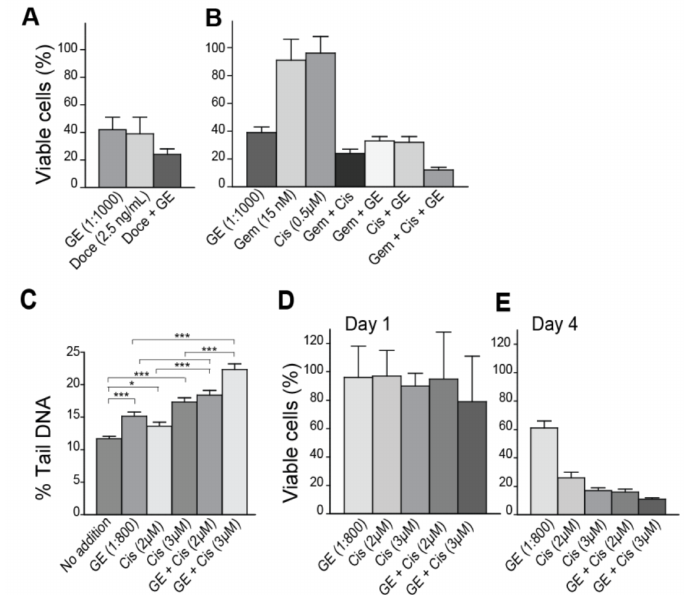
Figure 2. GE inhibits growth and increases the efficacy of genotoxic drugs in breast cancer cells. ( A , B ) Viability of the breast cancer cell line 67NR, measured by MTT-assay on day four, after the addition of ( A ) GE (diluted 1:1000), docetaxel (Doce) (2.5 ng/mL), and a combination of these at same concentrations; and ( B ) GE (diluted 1:1000), cisplatin (Cis) (0.5 µ M), gemcitabine (Gem) (15 nM), and double and triple combinations of these at the same concentrations. ( C ) Comet assay on 67NR cells on day one (16–20 h), after the addition of GE diluted at 1:800, alone and in combination with high dose cisplatin (Cis) (2 and 3 µ M). Data presented are from two independent biological replicas. Two tailed, unpaired t -test, *** p < 0.001, * p < 0.02. ( D , E ) Viability of 67NR cells measured by MTT-assay on ( D ) day one and ( E ) day four, after the addition of GE (diluted 1:800), alone and in combination with cisplatin (Cis) (2 and 3 µ M). All MTT data presented represent one experiment out of at least two similar experiments with the same results. Mean relative viability ± SD of 3–6 technical replicas are